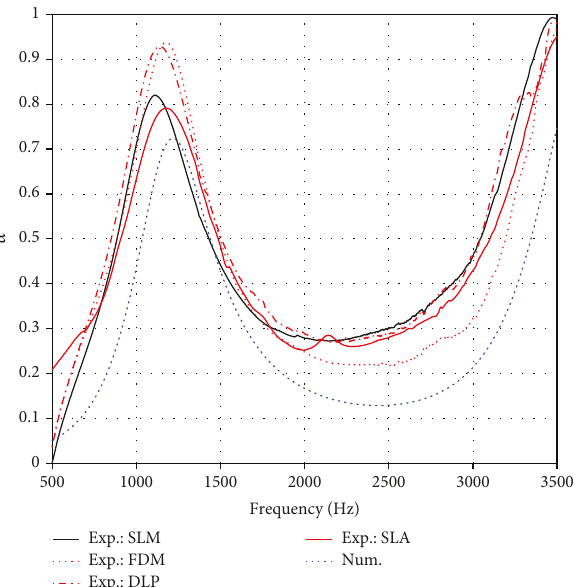
Figure 9: Absorption coe ffi cient for four di ff erent prints of the 10- layer-deep DENORMS cell.